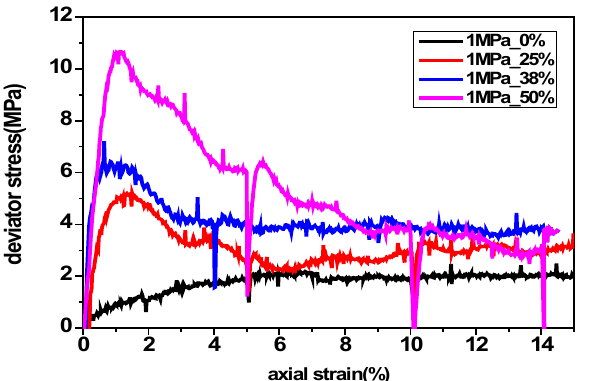
Figure 4. Stress–strain curves of hydrate-bearing sediments ( σ 3 = 1 MPa). Note: the sudden drop of stress in the curves is caused by the decrease of axial load during CT scan.